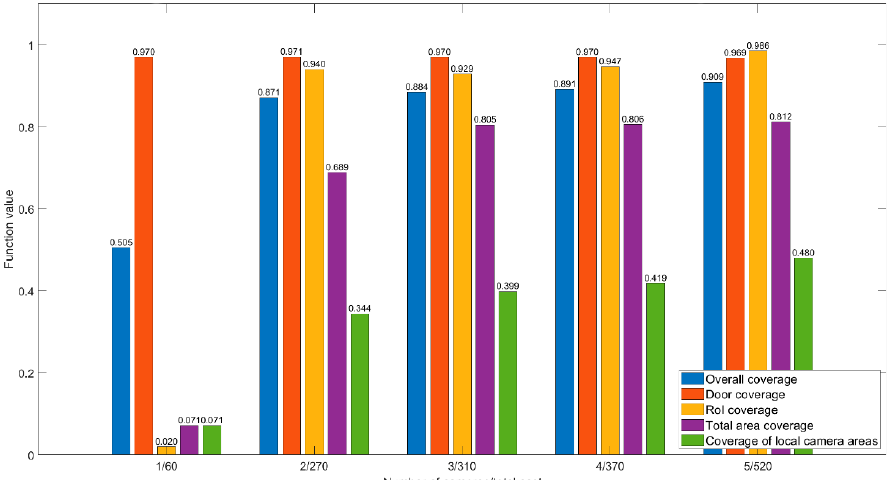
Figure 11. Function values for different number of cameras, room 2.